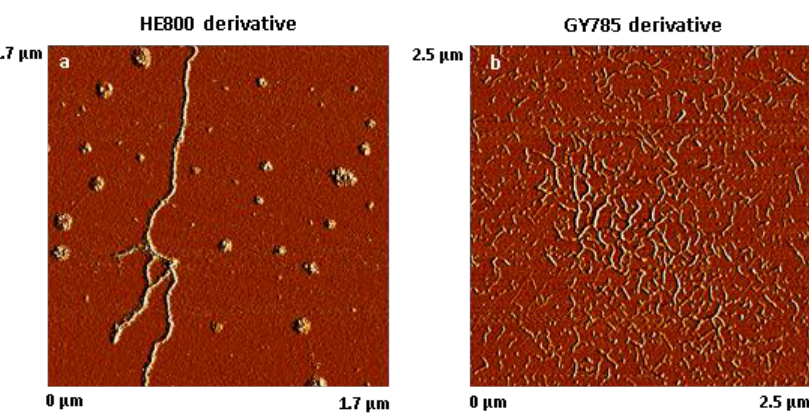
Figure 2. Atomic force microscope (AFM) images of dried, highly-diluted exopolysaccharides (EPS) solutions. ( a ) HE800 derivative (1.7 µm × 1.7 µm) and ( b ) GY785 derivative (2.5 µm × 2.5 µm).